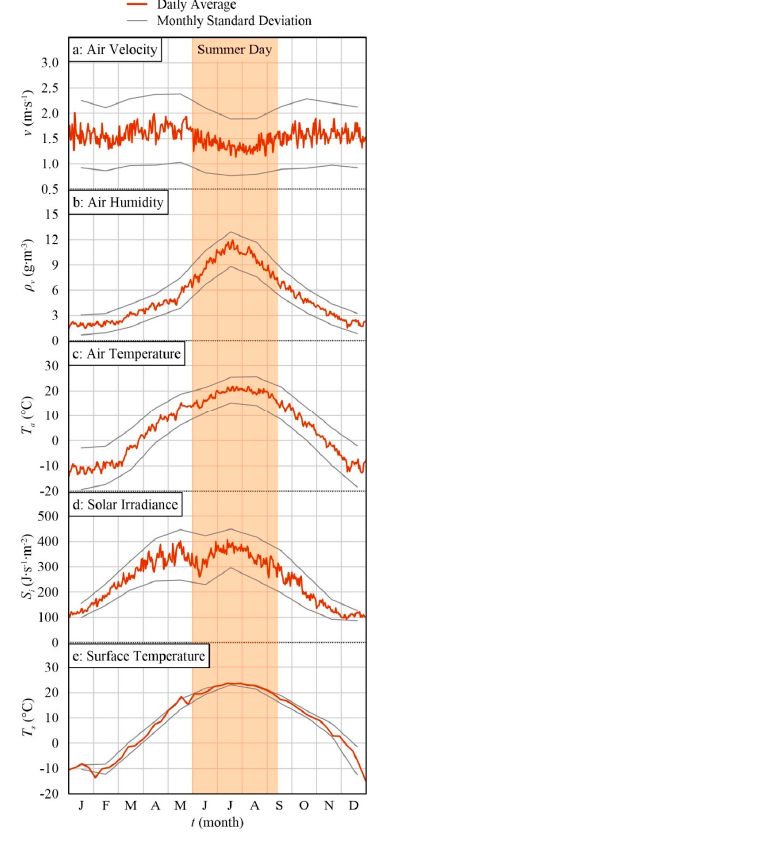
Figure 4. Typical day time atmospheric and water surface conditions in the study area: ( a ) air velocity, ( b ) air humidity, ( c ) air temperature, ( d ) solar irradiance, and ( e ) surface temperature. Table 1. Selected atmospheric parameters in the study area.